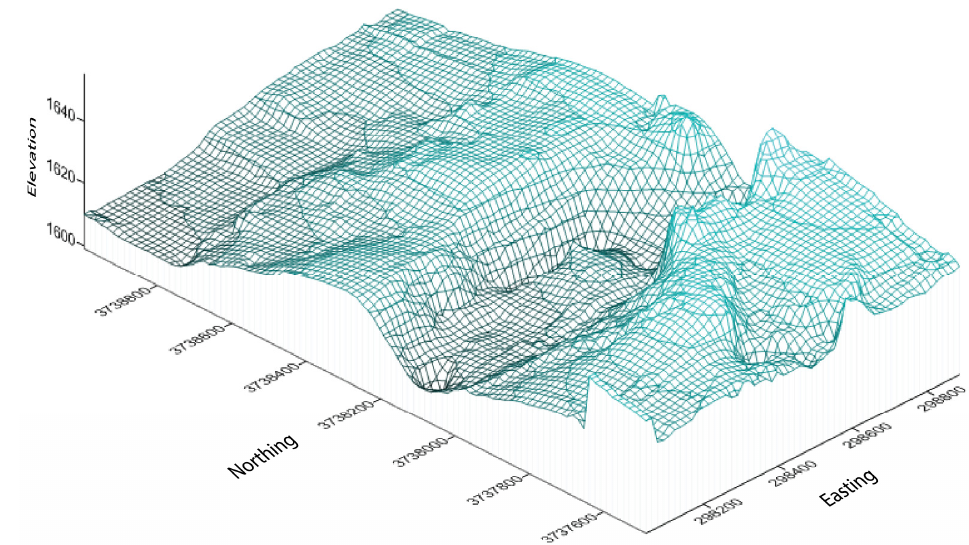
Figure 7. The 3D elevation map of UET Taxila. Contours were generated with the help of ArcGIS using the IDW analyst tool at an interval of three feet. The flow directions were found, and layered symbology of raster pixels was assigned. A total of eight classes of elevation raster were made to find out the flow path of rainfall. The contours and flow direction map is shown in Figure 8. This direction map highlighting the direction of flow indicates water movement from cell to cell. In most of northern zone, water flow direction was found in northwest whereas on southern region waterflow was predominantly in southeastern direction. This flow may be associated with the fact that spatially connected cells contribute to the flow direction based on slope of each cell resulting from the field survey. As a result, most of the pixels residing on top, will yield the flow direction towards low lying areas. Likewise, if the direction of steepest pixel is towards the left, the water flow will also receive the direction code (indicated with corresponding arrow) towards left. Also, resulting pixels with high flow directions kept on accumulating the water resulted in concentrated flow points as shown in Figure 8. On the other hand, all the pixels where flow direction do not indicate any accumulation were indication of the ridges where the potential recharge was